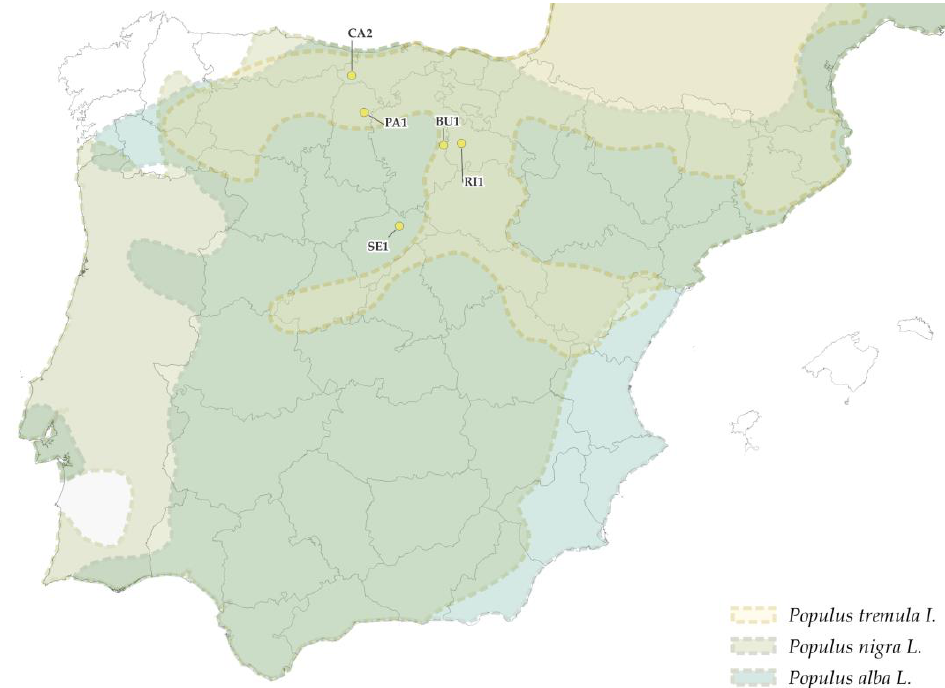
Figure 9. Distribution map of the species Populus tremula I., Populus nigra L., and Populus alba L. and location of the case studies identified as belonging to this group of species. Map drawn up by the authors using information obtained from the database Chorological Data for the Main European Woody Species [42].